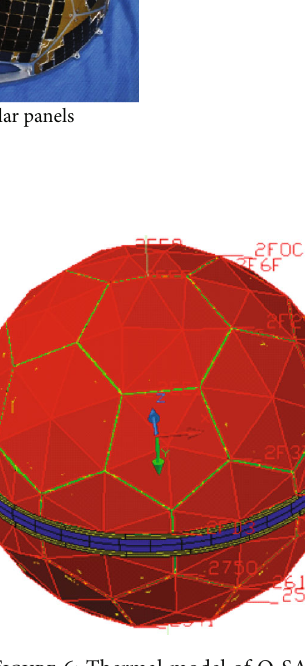
Figure 6: Thermal model of